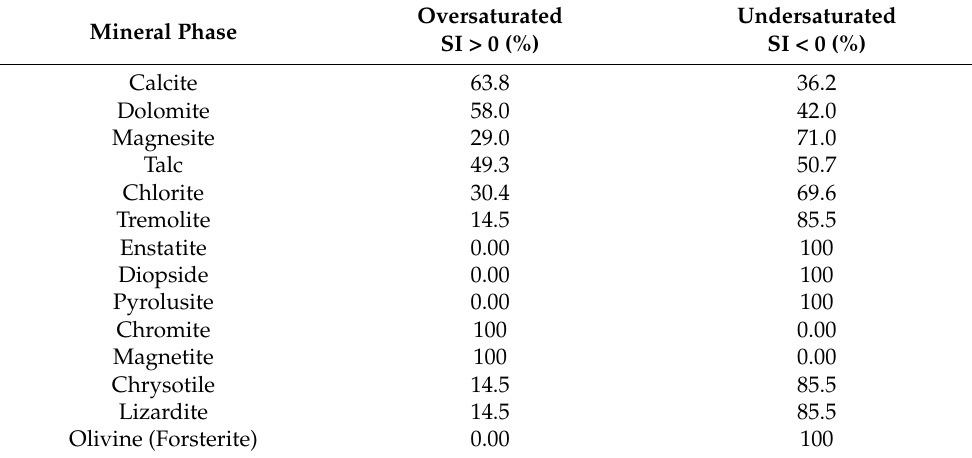
Table 6. The percentage distribution of the saturation state with respect to the selected mineral phases in the collected water samples. Mineral